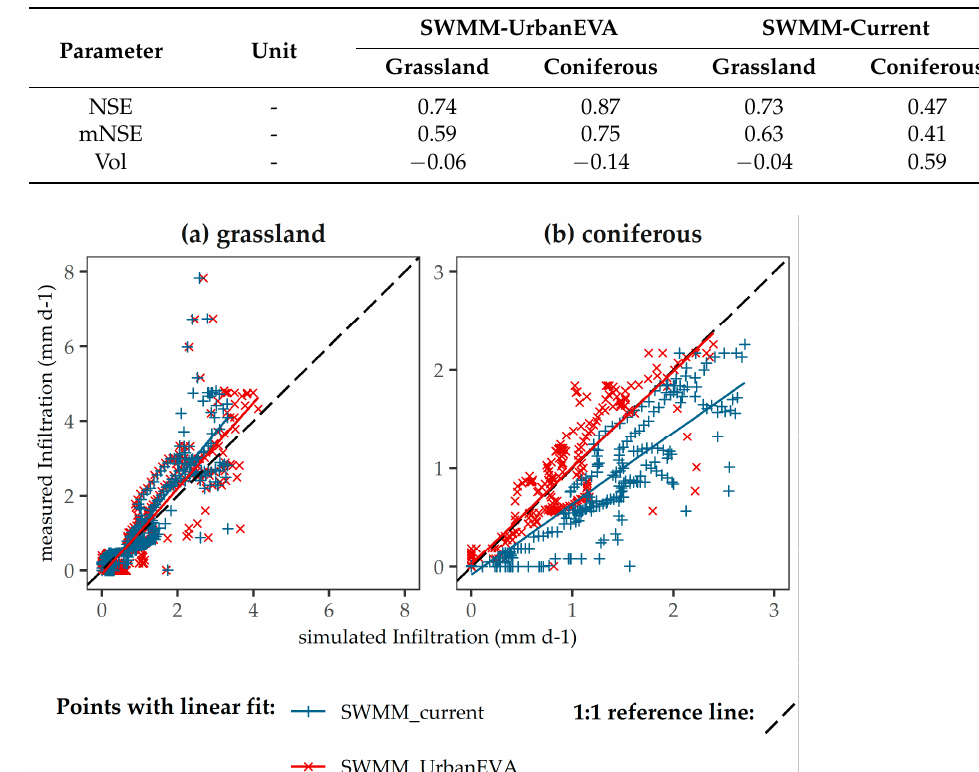
Figure 7. Measured and modeled infiltration in 1992 for calibrated models of ( a ) grassland and ( b ) coniferous at full scale lysimeter St. Arnold. Table 9. Performance criteria for measured and modeled infiltration of calibrated models in 1992.